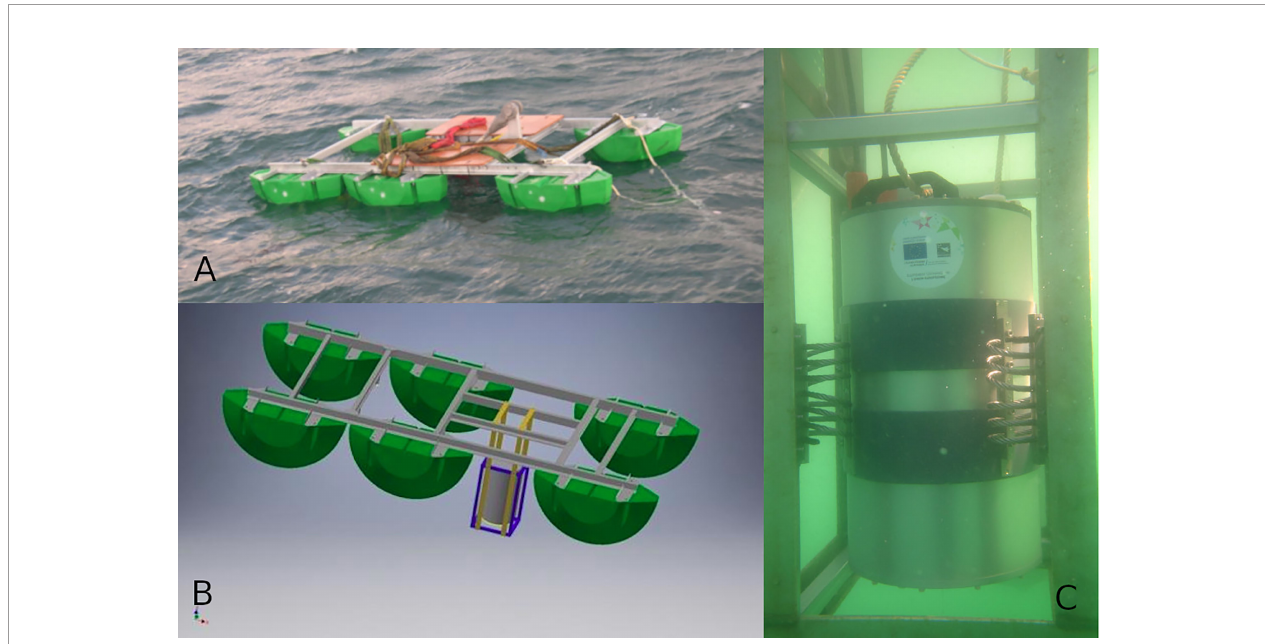
FIGURE 1 | Picture of the deployment of the PRIMROSE mooring platform at Anse du Roz in the Daoulas estuary (A) and scheme (B) showing details of the fl oating structure frame designed for carrying the autonomous fl ow cytometer, IFC (C) , its associated tools (batteries, etc) and other additional